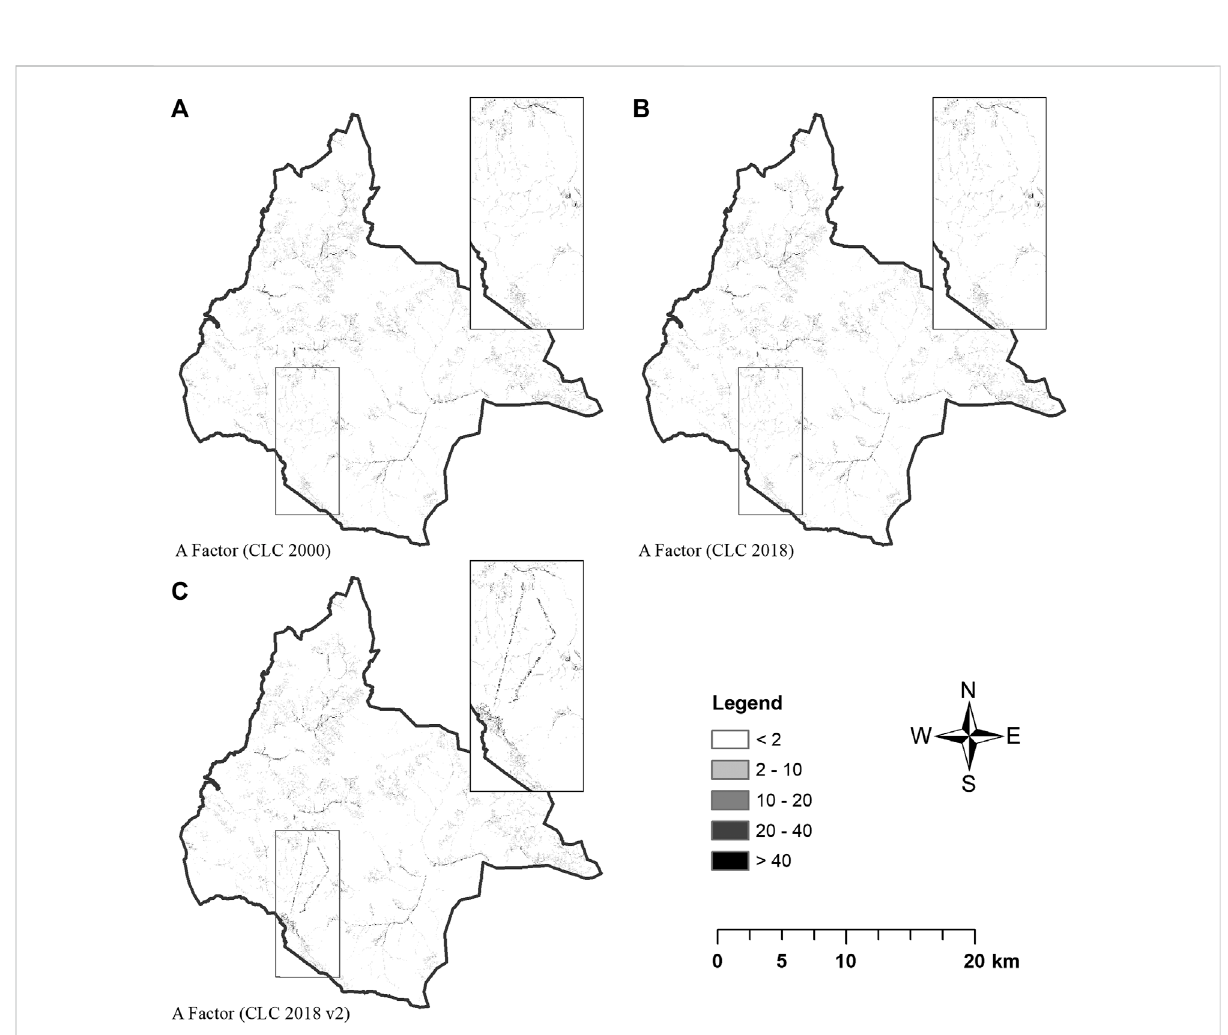
FIGURE 4 Distribution maps of average annual soil loss rate in Pale Municipality (A) according to CLC 2000; (B) according to CLC 2018; (C) according to CLC 2018